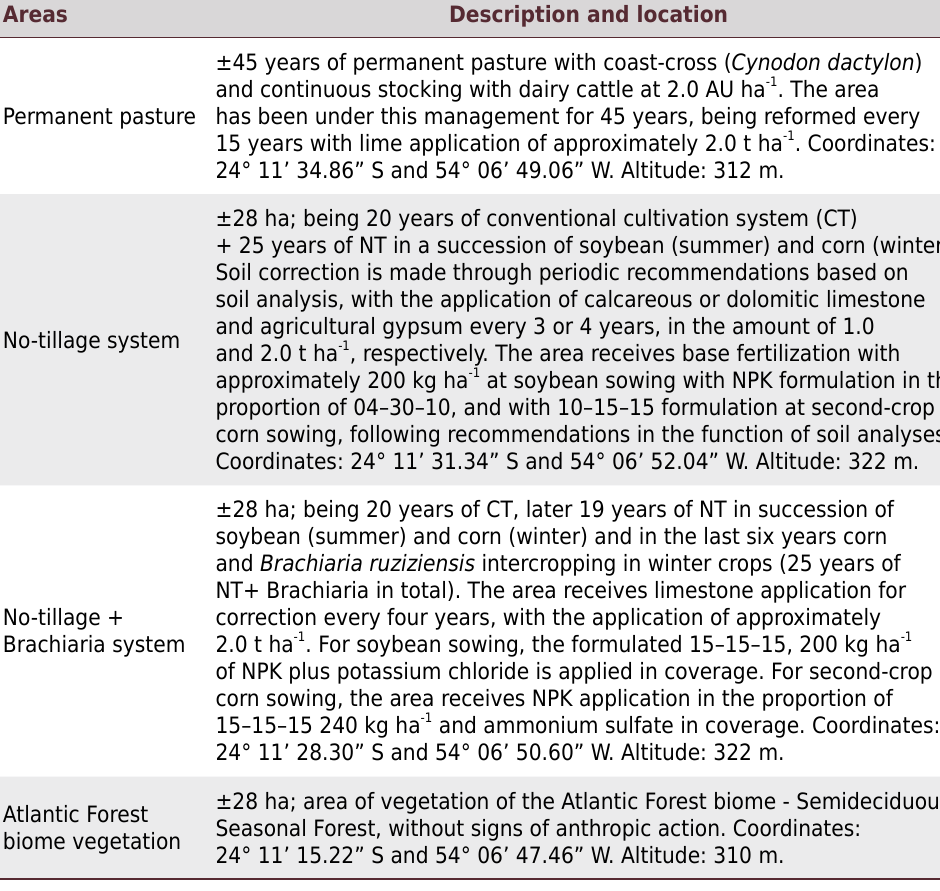
Table 1. History, description and location of the sample areas Areas Description and